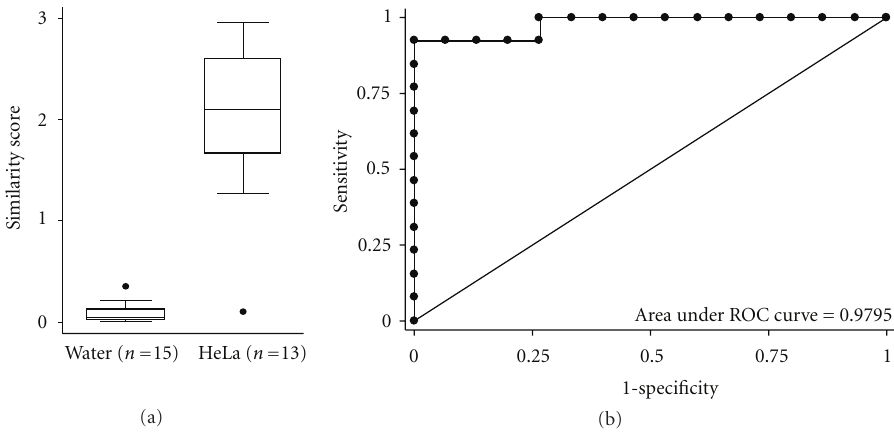
Figure 1: Array performance for HPV18. (a)Clear demarcation amongsimilarityscores between positive and negative samples.(b) Receiver- operating characteristic curve for HPV18.